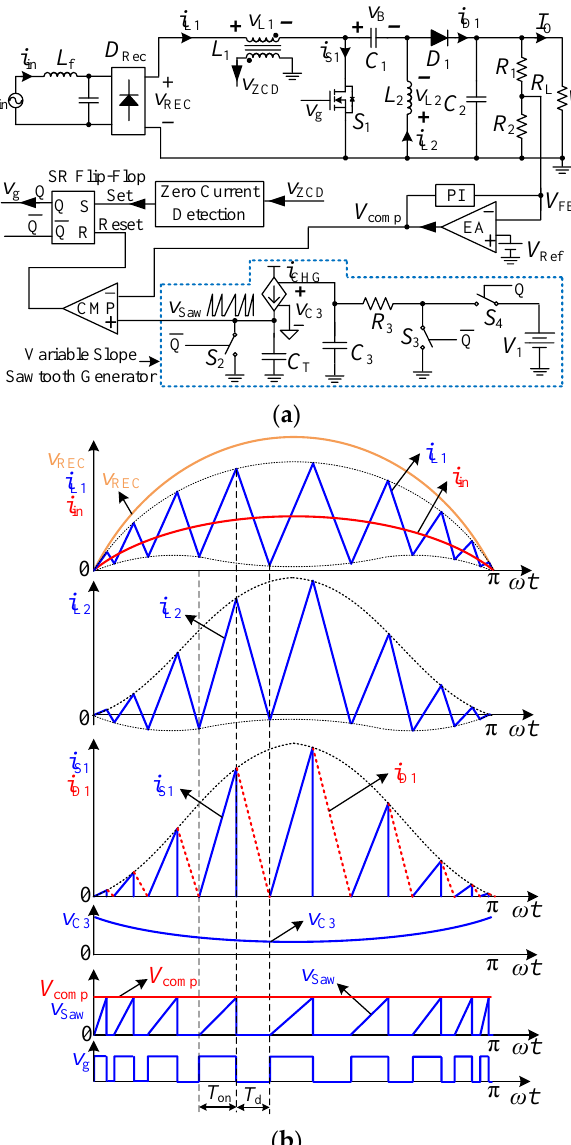
Figure 4. Block diagram and main waveforms of BCM SEPIC PFC converter with VOT control. ( a ) Block diagram; ( b ) Key waveforms during half line cycle.